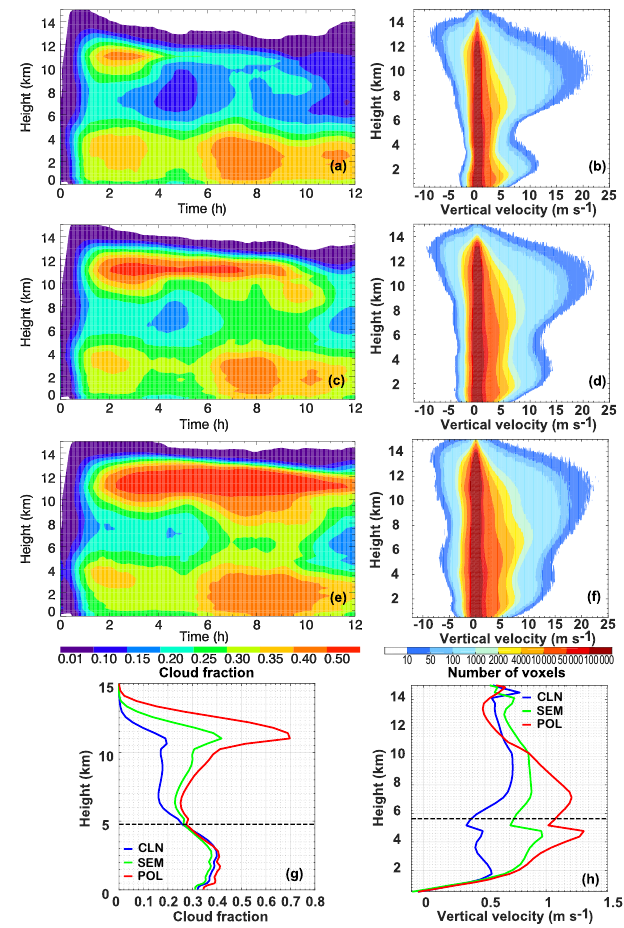
Figure 3. (a) Time series of the vertical profiles of a cloud fraction. (b) Frequency of air vertical velocity per altitude from the clean simulation results. Panels (c, d) and (e, f) are similar to panels (a, b) for the semi-polluted and polluted simulations, respectively. Pan- els (g) and (h) are vertical profiles of the mean cloud fraction and mass-weighted mean vertical velocity from 4 to 12h of the simula- tion in all